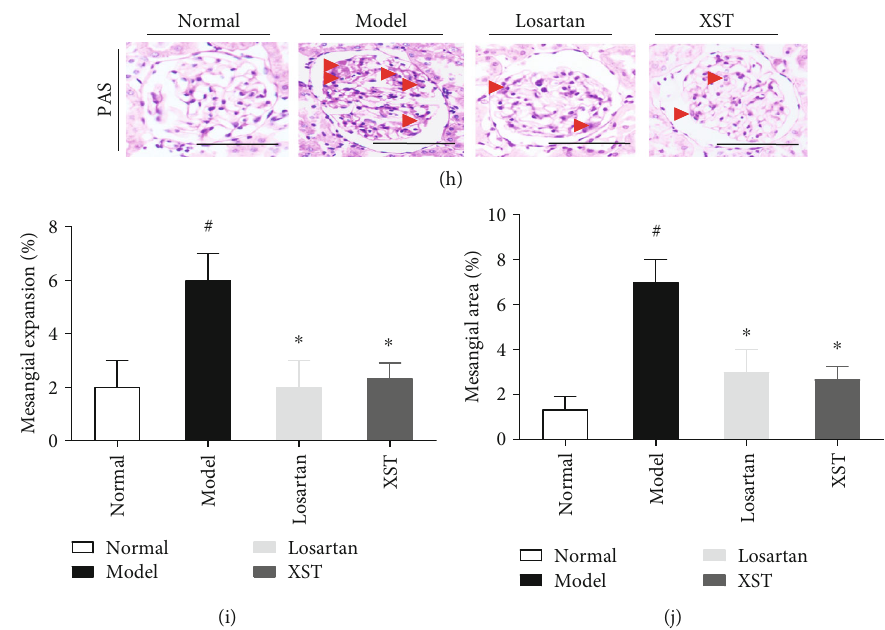
Figure 1: E ff ects of XST on physical and biochemical parameters, as well as renal histopathology in diabetic rats. E ff ects of XST on urinary ACR (a), kidney weight/body weight ratio (b), BUN (d), serum creatinine (e), and ALT (f) in diabetic rats. Blood glucose at baseline in rats (c). Representative HE (g) and PAS (h) staining of kidney sections. Representative quantitative analysis for mesangial matrix expansion (i, j). Normal: normal control rats; model: STZ-induced diabetic rats; Losartan: diabetic rats treated with Losartan; XST: diabetic rats treated with Xuesaitong. XST (5mg/kg · d) or Losartan (10mg/kg · d) was intragastrically administrated once daily for 12 weeks. ACR: albumin/creatinine ratio; BUN: blood urea nitrogen; ALT: alanine aminotransferase. Scale bar = 100 μ m. Red arrowheads indicated mesangial expansions. Results were expressed as the means ± SEM ( n = 8 ). # P < 0 : 05 vs. normal; ∗ P < 0 : 05 vs.